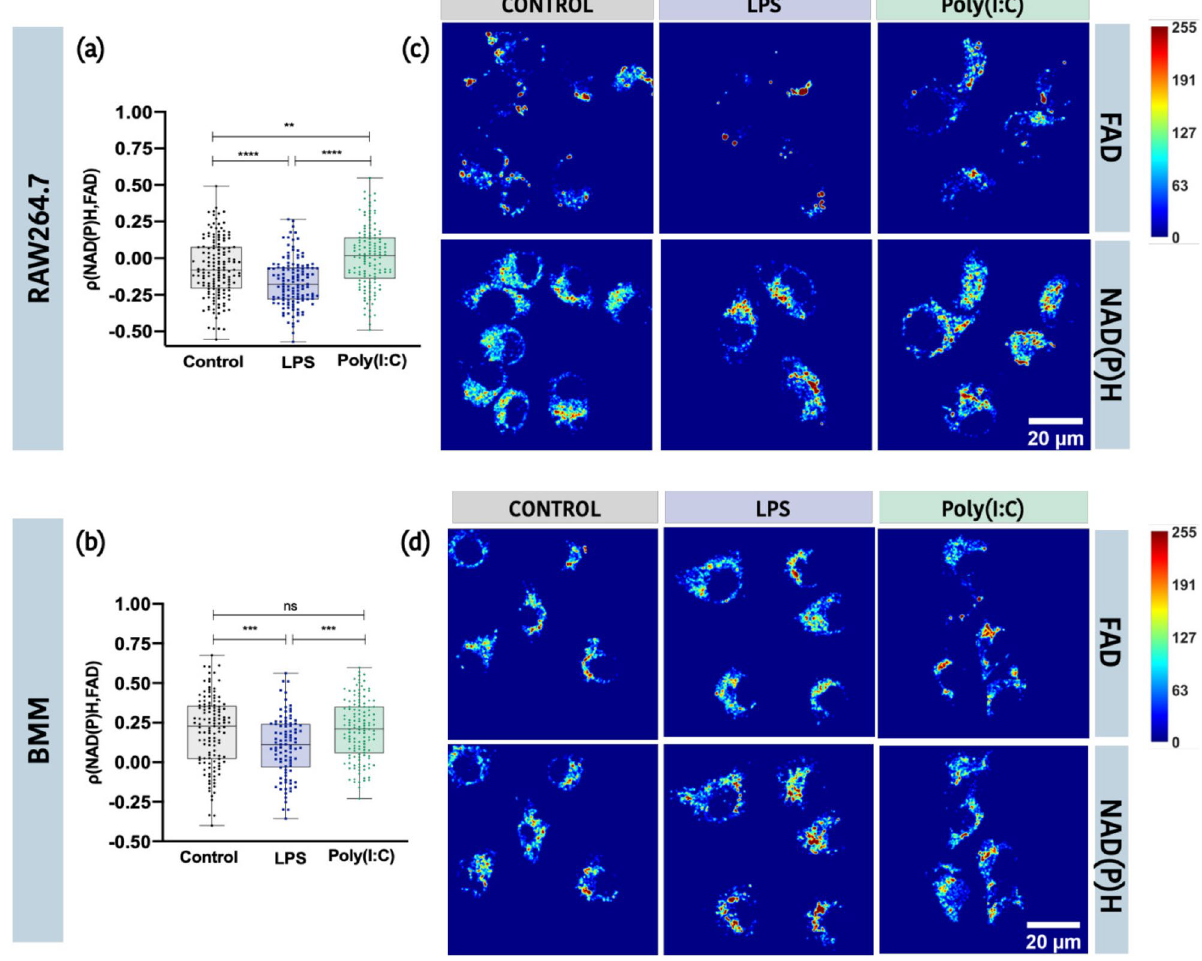
Figure 4. Analysis of the spatial correlation between the FAD-TPEF and NAD(P)H-TPEF intensities in each cell. Correlation between FAD-TPEF and NAD(P)H-TPEF intensities for Control, LPS, and Poly(I:C) treated cells for ( a ) RAW264.7 cells and ( b ) BMM cells (*p ≤ 0.05, **p ≤ 0.01, ***p ≤ 0.001, ****p ≤ 0.0001). Representative images of RAW264.7 cells (Top panel ( c )) and primary BMM (Bottom panel ( d )) shown in a thermal colour palette. In each panel, the top row is FAD channel and bottom row is NAD(P)H channel with Control, LPS and Poly(I:C) treated cells from left to